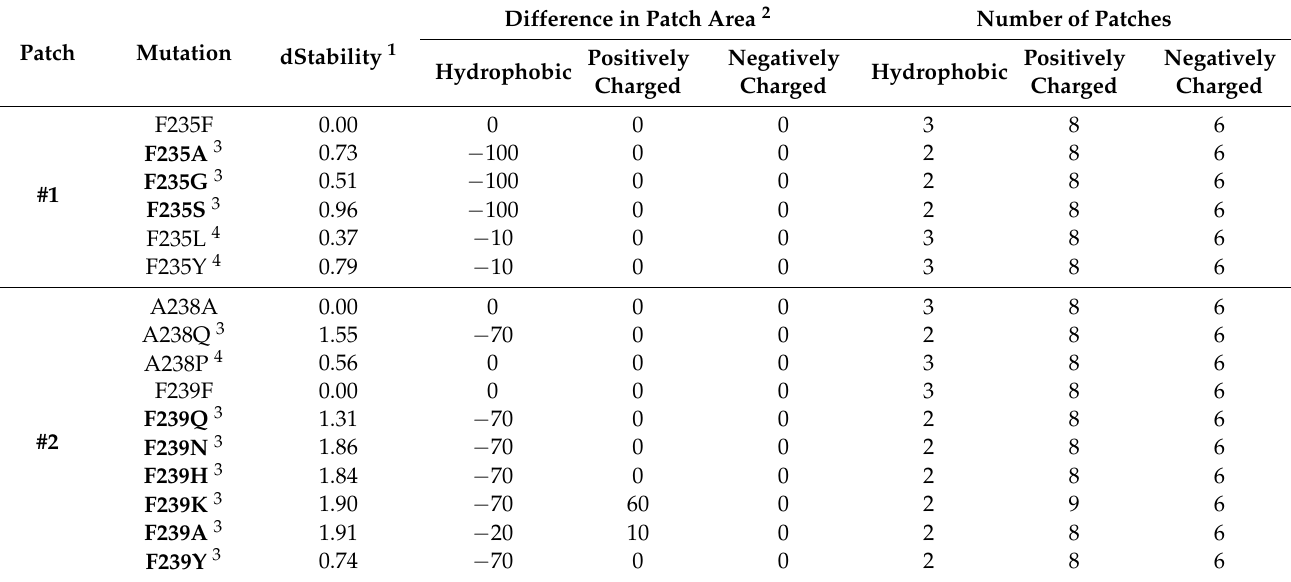
Table 1. Patch properties and effects of amino acid